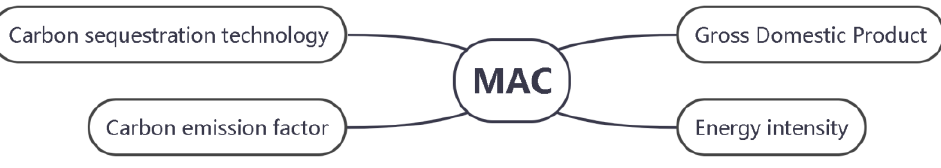
Figure 3. Four main components of the MAC curve.